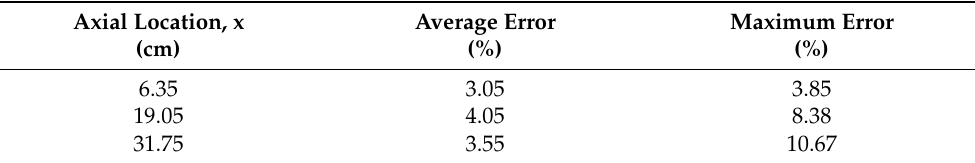
Table 4. Percentage error between the EPS models’ predicted and experimental temperatures at an air speed of 2.71